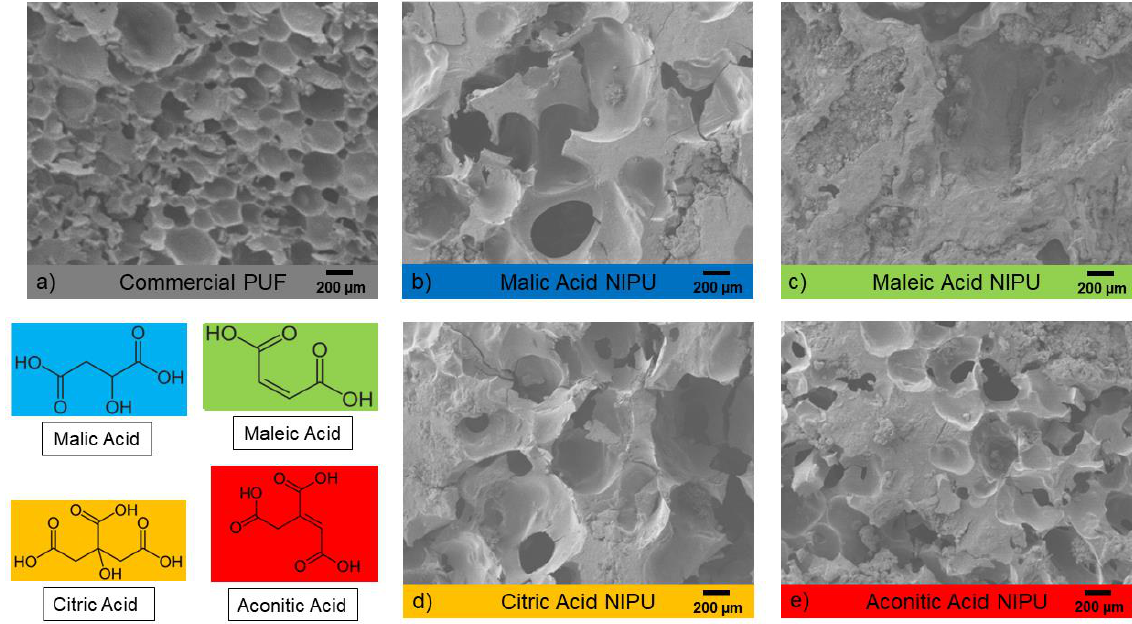
Figure 3. SEM images of each type of polyurethane foam